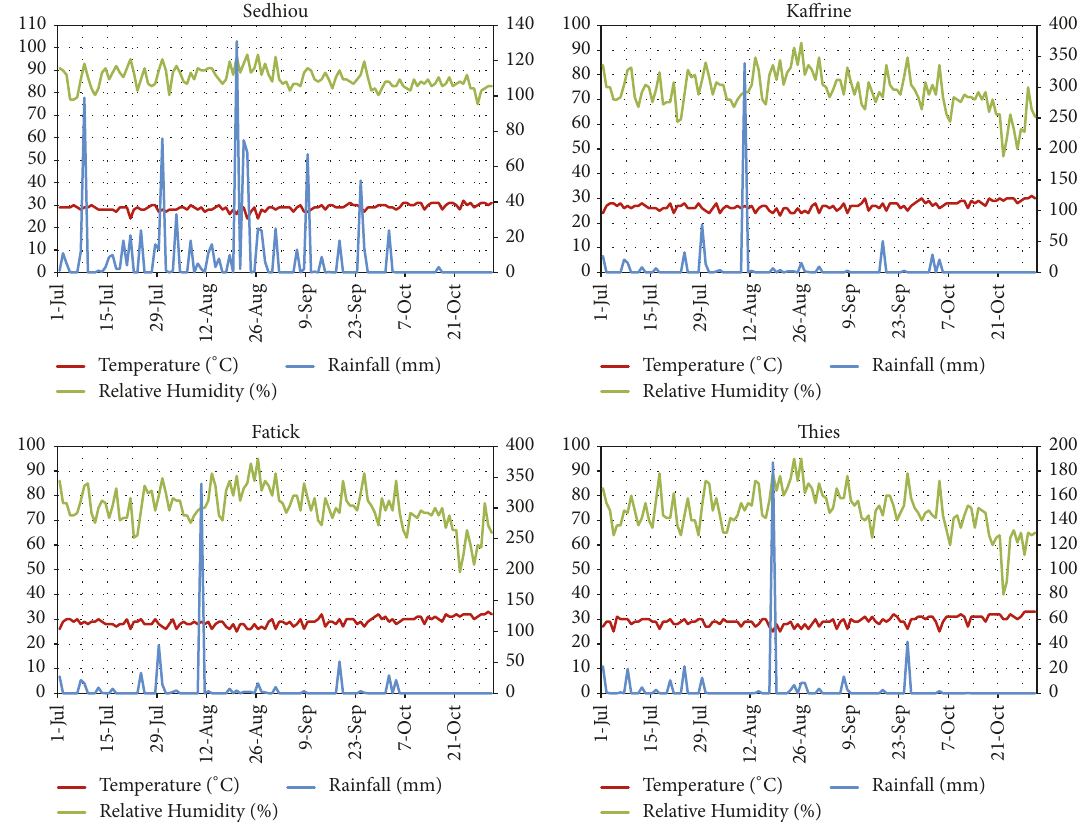
Figure 4: Daily temperature, relative humidity (both at left-side of the Y-axis), and rainfall (right-side of the Y-axis) in Sedhiou, Thies, Kaffrine, and Fatick during rainy season 2017. Table 1: Prevalence of downy mildew across surveyed regions of Senegal following longitude and latitude gradient during rainy season 2017. Field surveyed Area surveyed (m 2 Region